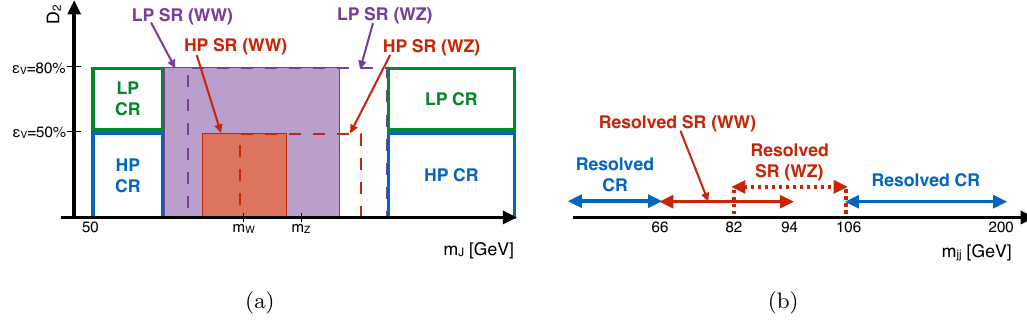
Figure 1 . (a) Illustration of the merged WW (shaded area) and WZ (dashed lines) signal regions (SR) according to the large- R jets selection. The 50% and 80% V -tagging e(cid:14)ciency ( " V ) working points, based on the combined cut of the D 2 and m J , are used to form the high-purity (HP) and low-purity (LP) regions respectively. For each working point, a jet mass requirement is imposed and an upper bound on the substructure variable is set. Since both requirements depend on the p T of the large- R jet, an absolute de(cid:12)nition is not given in the (cid:12)gure. (b) De(cid:12)nitions of the resolved WW and WZ SR based on the dijet mass selection. In both channels, the SR mass sidebands are used to de(cid:12)ne the W +jets control region